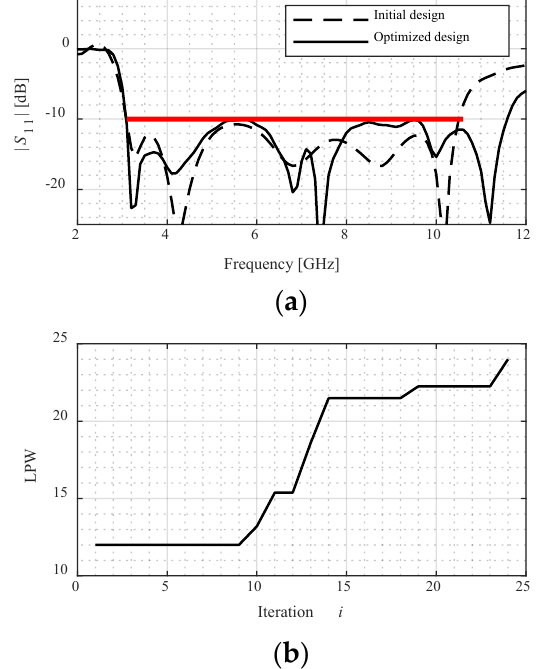
Figure 8. Numerical results obtained for Antenna II using the proposed algorithm incorporating multi-fidelity model management and adaptive penalty coefficients: ( a ) reflection responses, ( b ) evolution of the model fidelity. The horizontal line represents the design specifications.